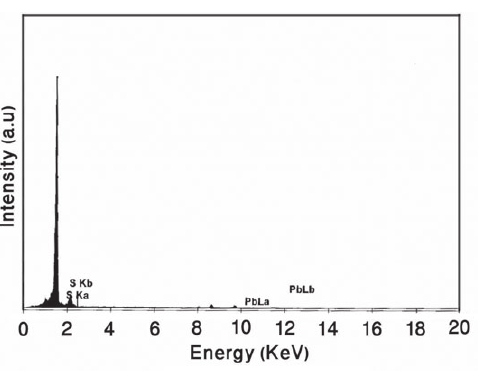
Figure 6 Room temperature photoluminescence spectrum of the obtained PbS with 1 m of